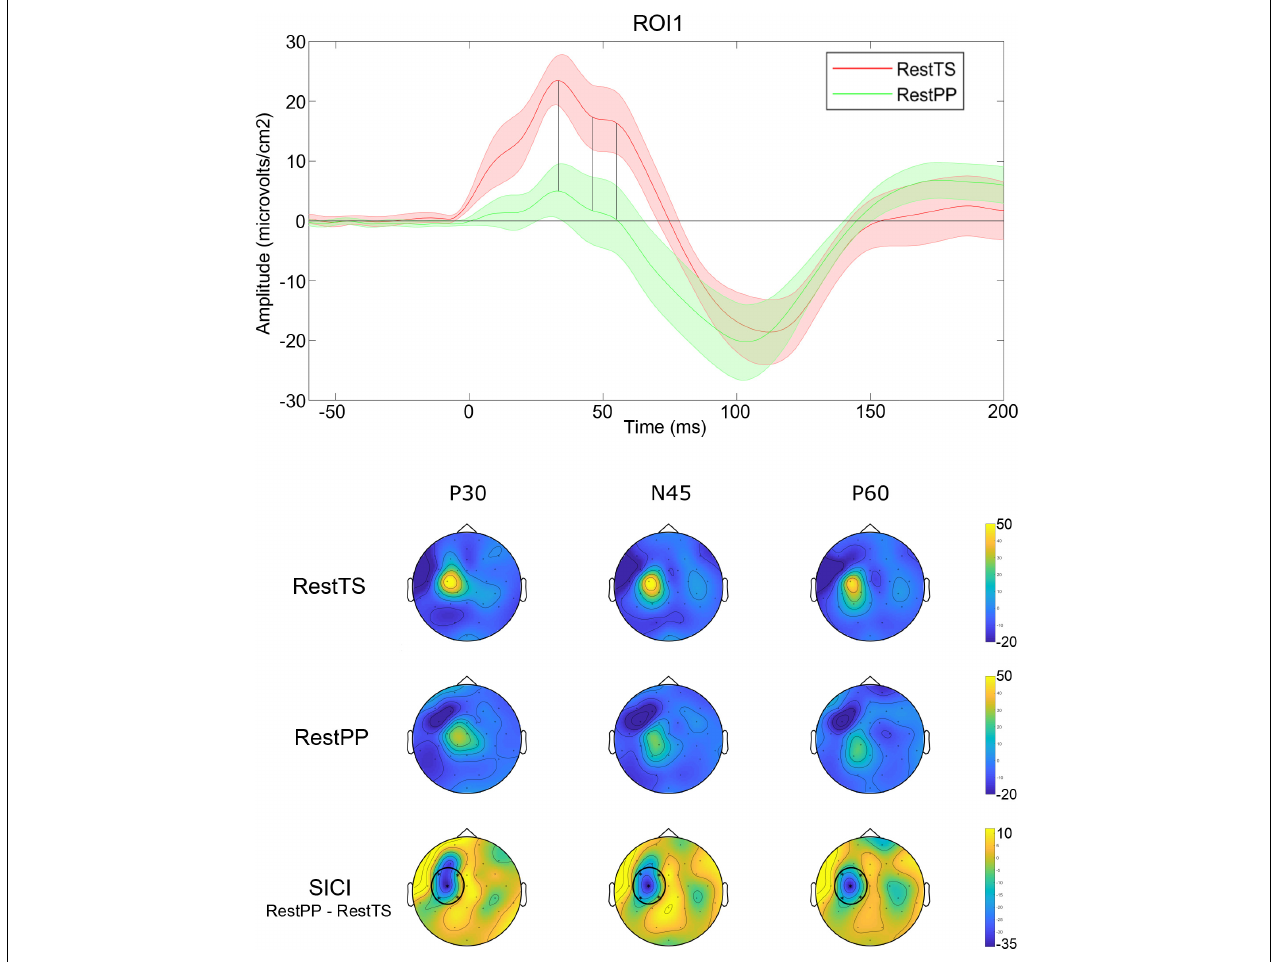
FIGURE 4 | SICI related modulation of TEPs. Upper panel: Averaged TEP in ROI 1 at RestTS (red) and RestPP (green) (mean ± SE). P30, N45, and P60 were significantly modulated during SICI (vertical lines). Lower panel: topographic representation of current source density (CSD) for P30, N45, and P60 at RestTS (first row), RestPP (second row), and the effect of SICI (third row). ROI significantly modulated by SICI is highlighted (ROI1) (yellow, positive values; blue, negative